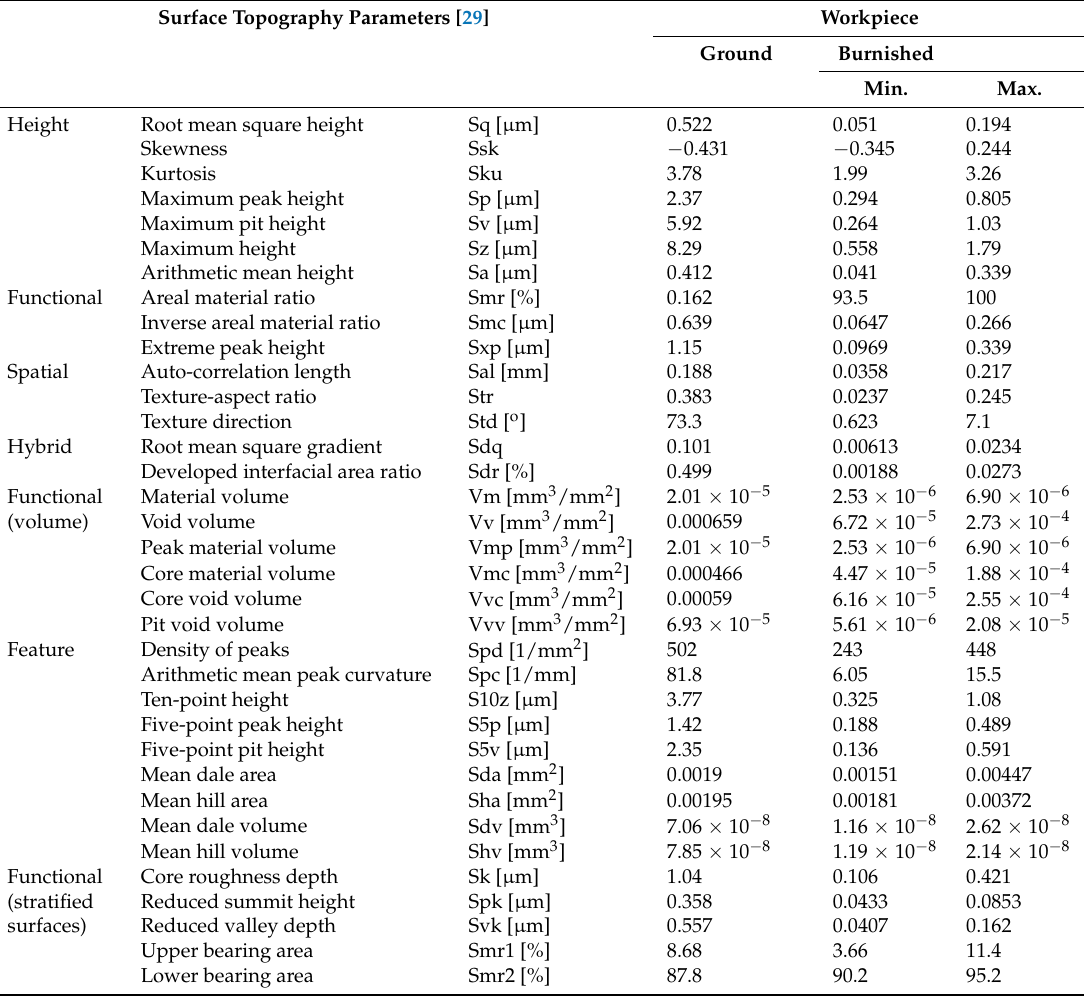
Table 3. Comparison of surface texture parameters of ground and ball-burnished